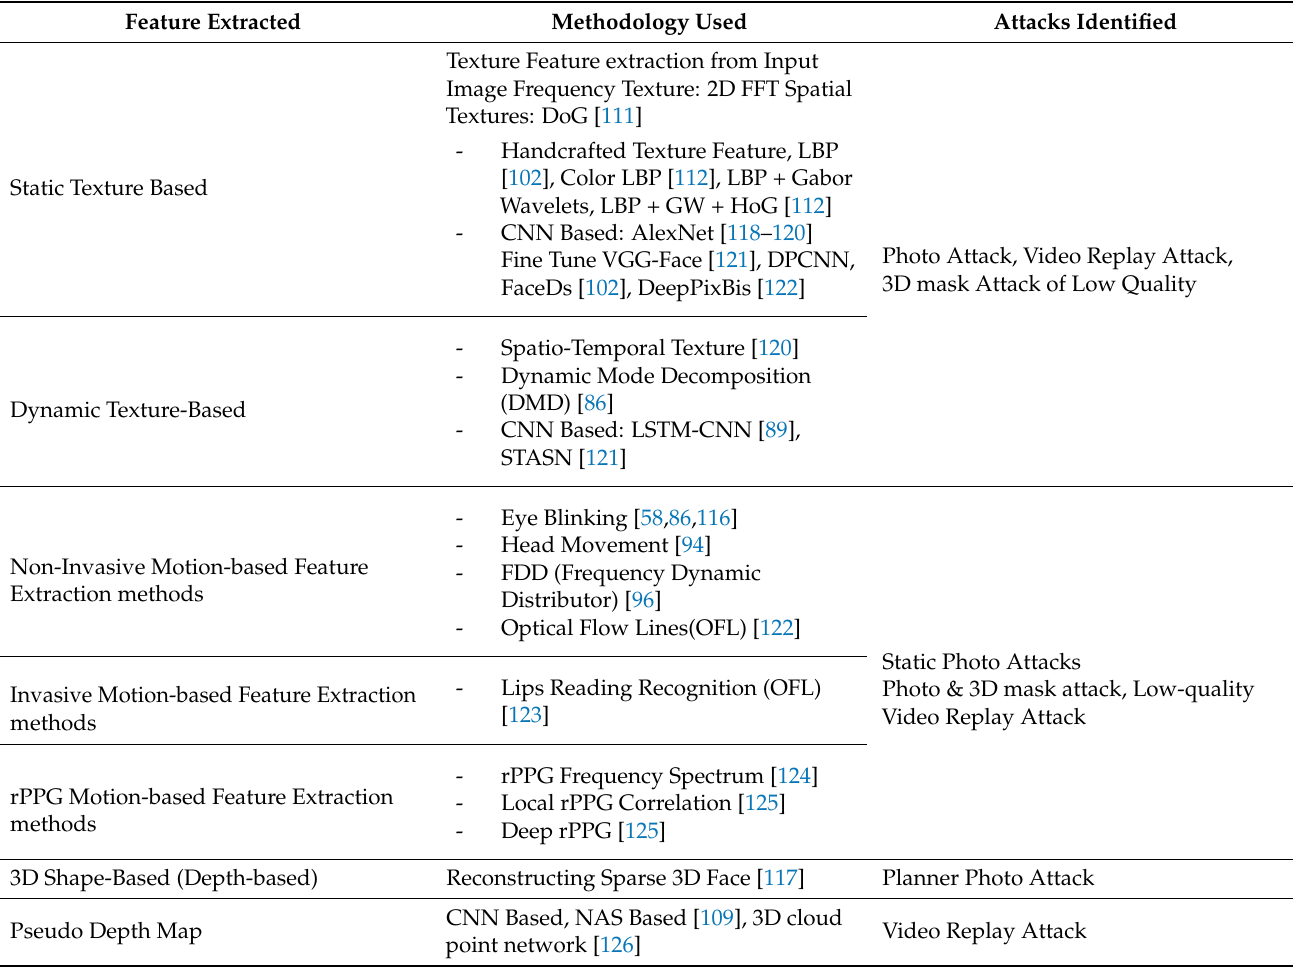
Table 8. Categorization of extraction methods for face liveness